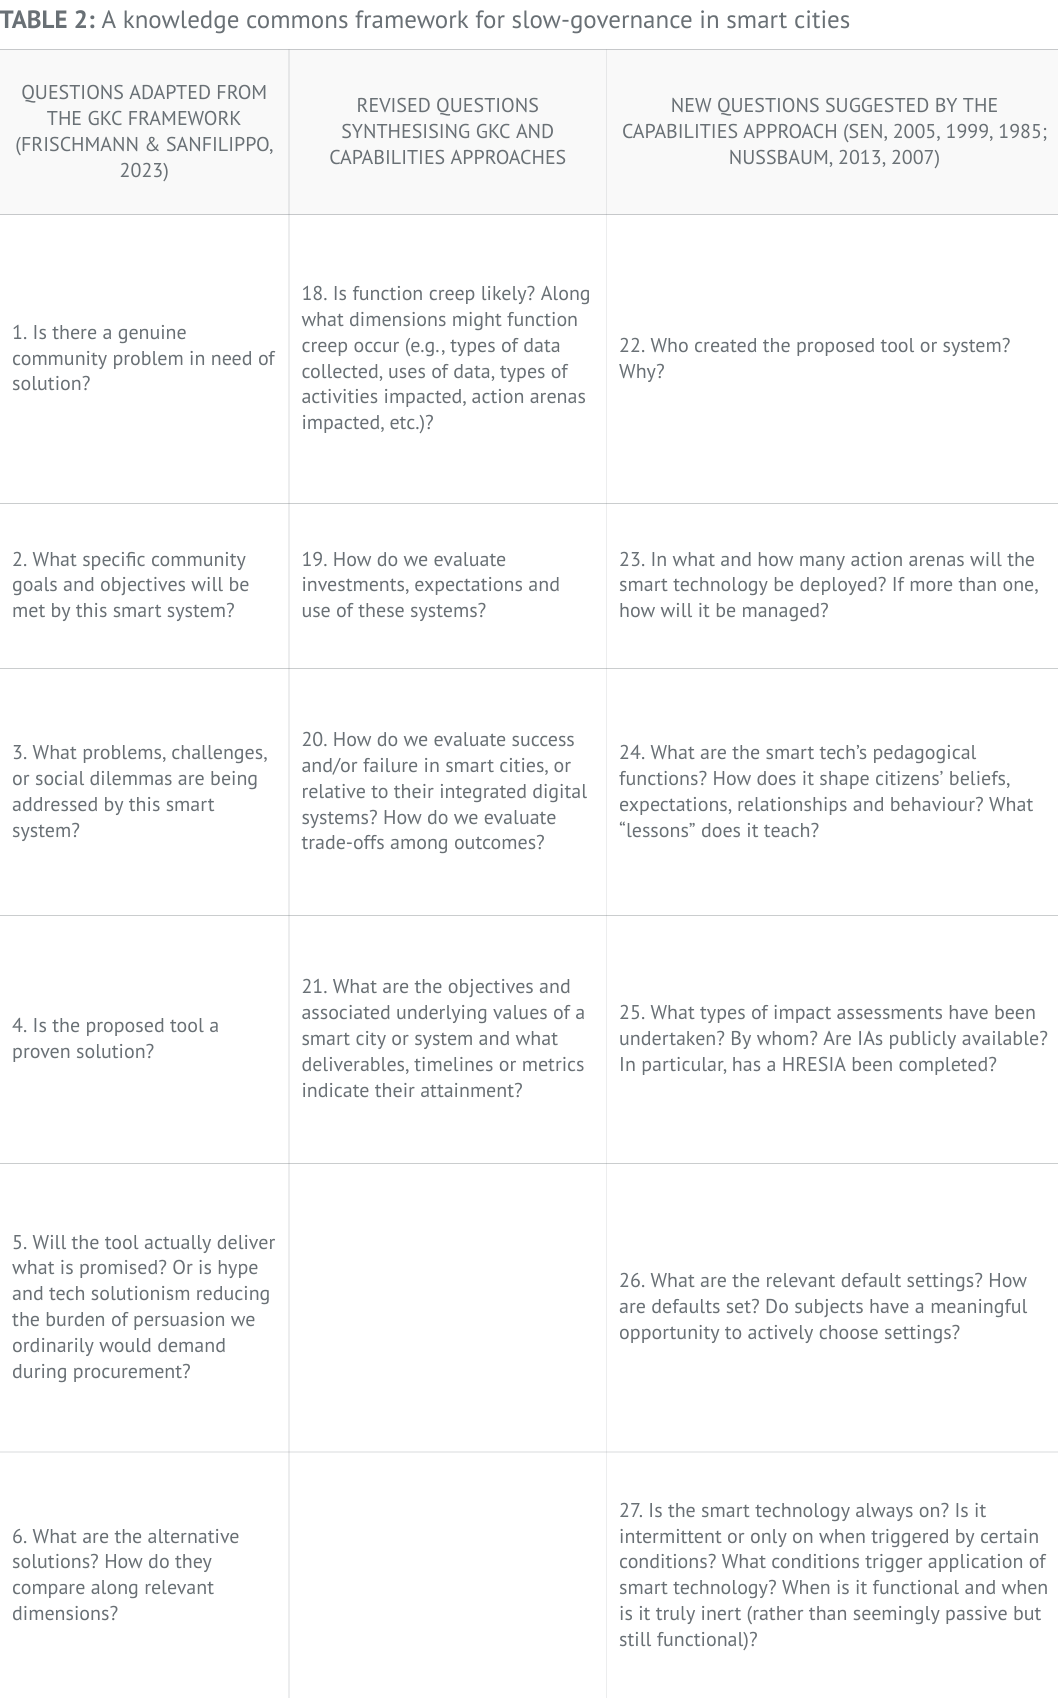
TABLE 2: A knowledge commons framework for slow-governance in smart cities QUESTIONS ADAPTED